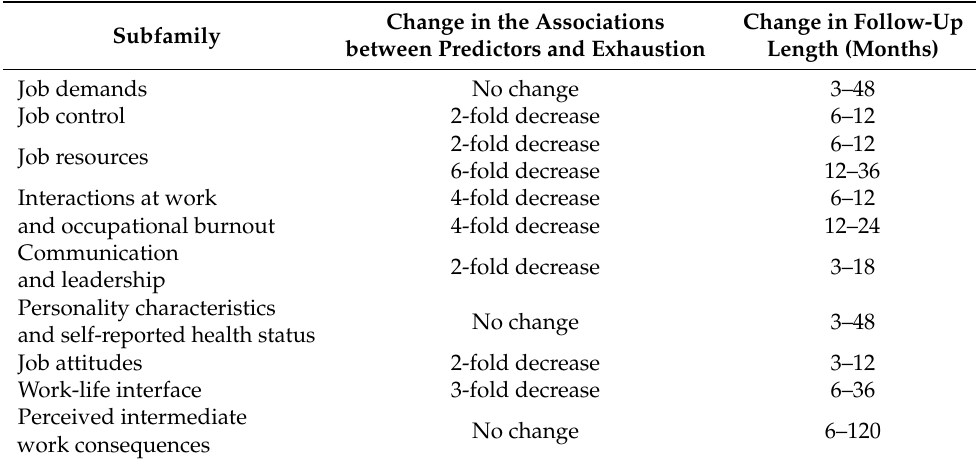
Table 2. Summary of the effect of different follow-up lengths on the association between subfamilies of predictors and